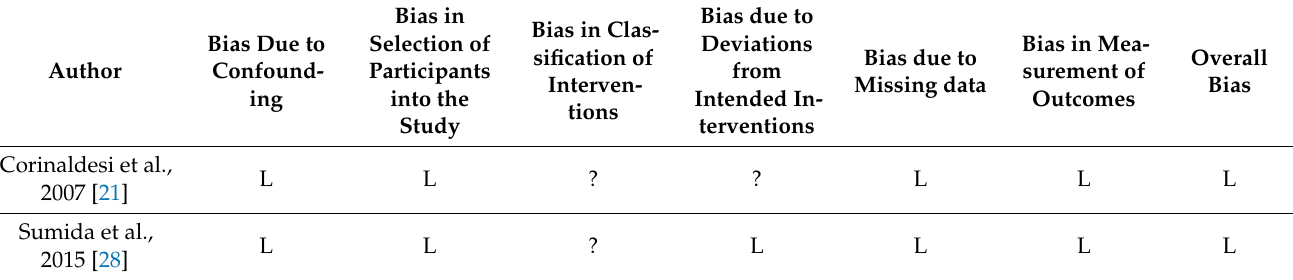
Table 3. Risk of Bias of included non-randomized clinical